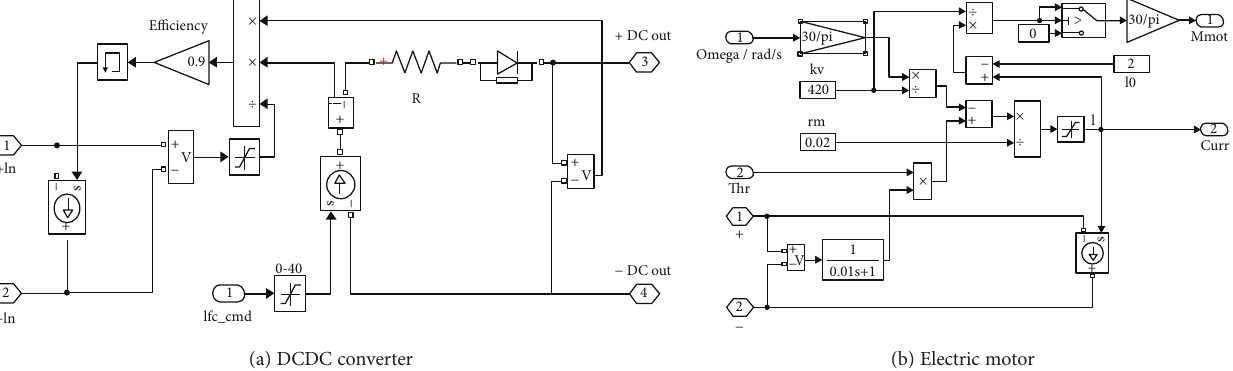
Figure 6: Topology of the DCDC converter and electric motor.